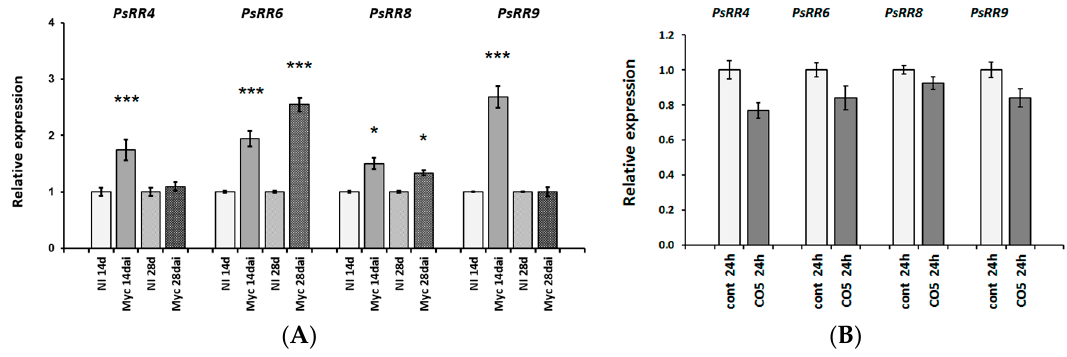
Figure 9. Relative expression of type-A cytokinin response regulator genes PsRR4 , PsRR6 , PsRR8 , PsRR9 was determined using qRT-PCR. ( A ) Analysis of pea roots on 14 and 28 days after inoculation with Rhizophagus irregularis (dai). NI, not inoculated; ( B ) Effect was estimated in pea roots treated with 10 − 5 M CO5 for 24 h. As a control mock-treated roots were used. The relative expression was normalized against the constitutively expressed ubiquitin and actin genes. Asterisks indicate statistically significant differences compared with control (not inoculated or not treated plants): *** p < 0.001, * p < 0.05.